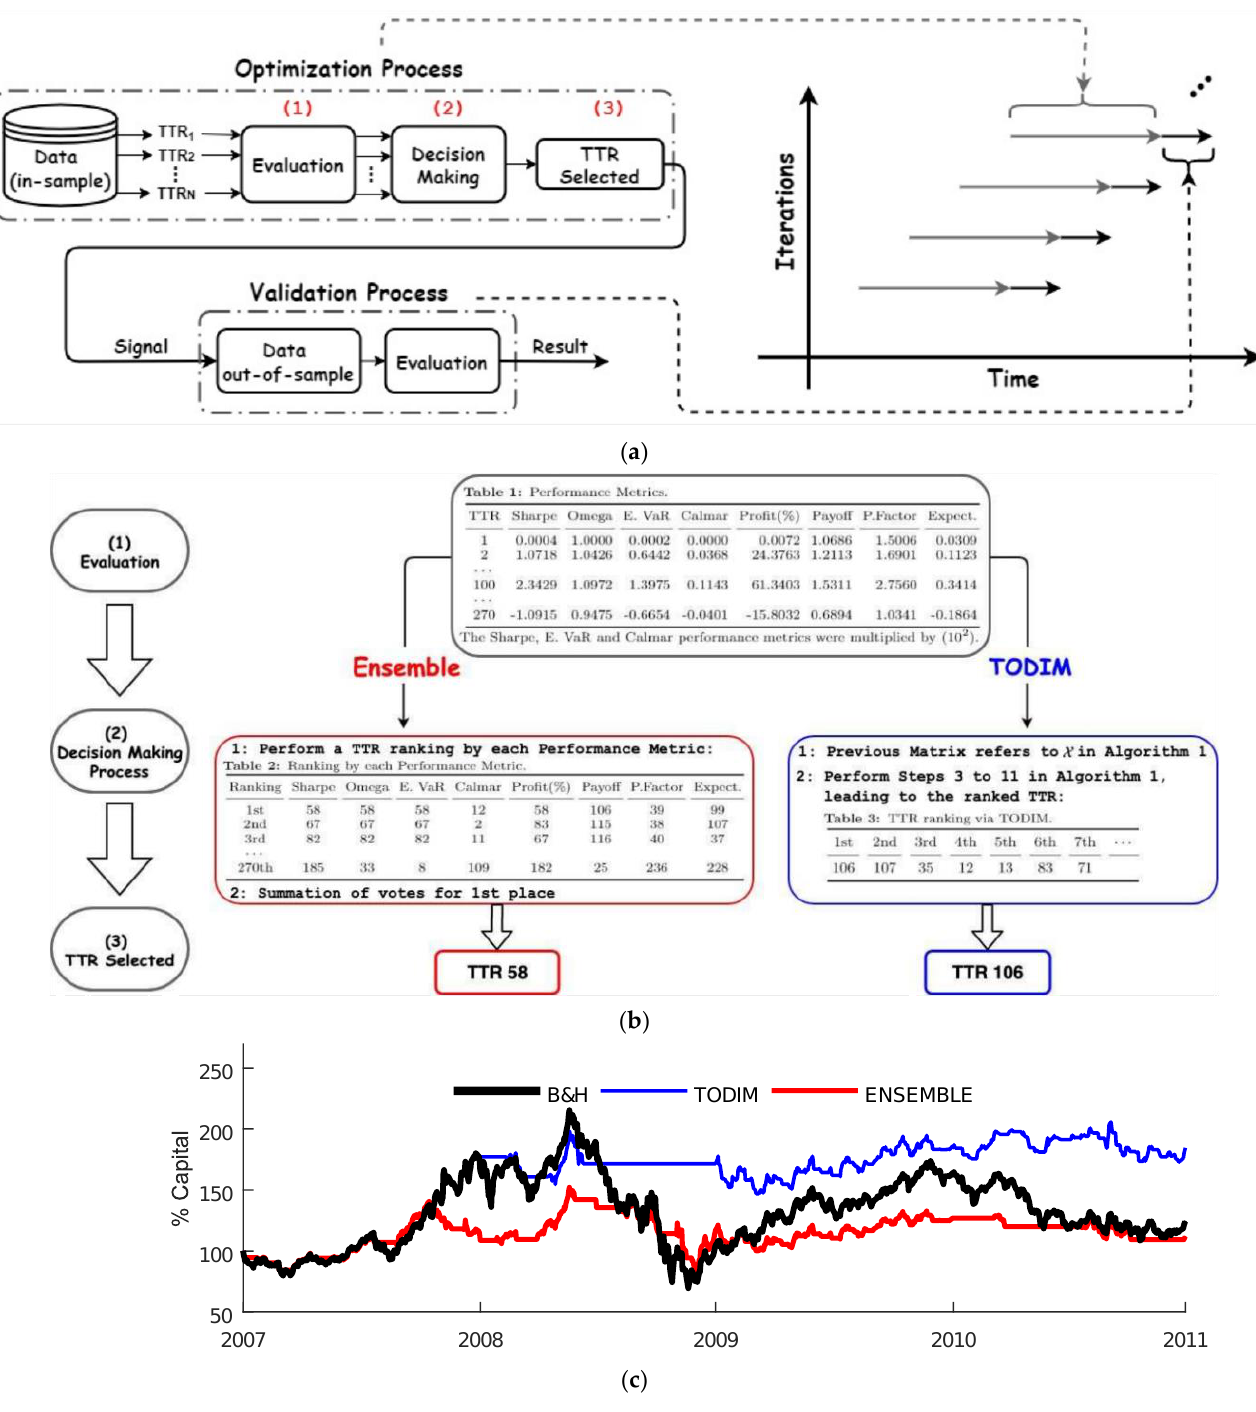
Figure 2. Details of the proposed approach compared with the methodology used in [21] for a multicriteria trading system design. ( a ) Trading system simulation based on the walk forward method. ( b ) Optimization process detailed. Comparison of ensemble method [21] and the proposed approach. Although the two methods are based on the same matrix, the two multicriteria approaches might choose different TTRs at each iteration. ( c ) Capital curves depicting one of the simulations: the time series under analysis (black color) and two methodologies for the trading system development discussed. TODIM refers to the proposed approach, while ENSEMBLE indicates the method of [21].